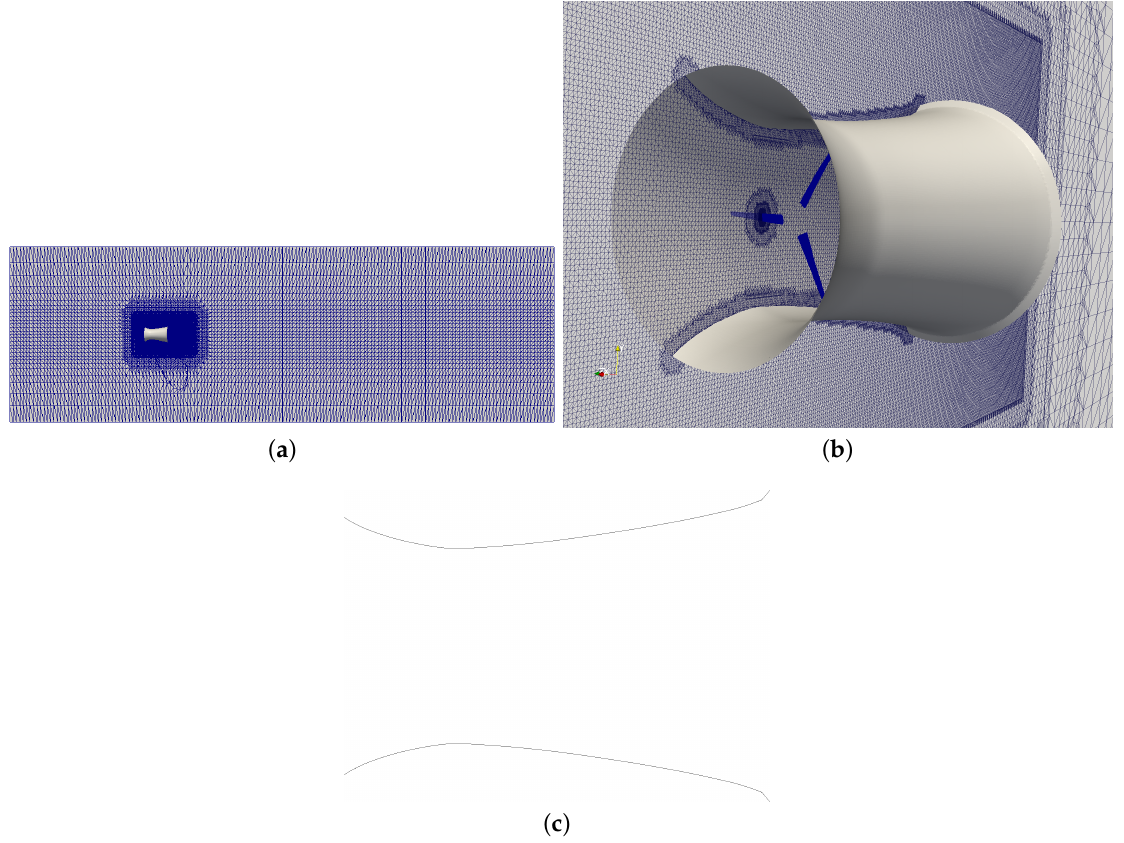
Figure 3. Ducted turbine mesh. ( a ) The whole meshed domain sliced in the middle. ( b ) The mesh near the ducted turbine. ( c ) Cross section of the